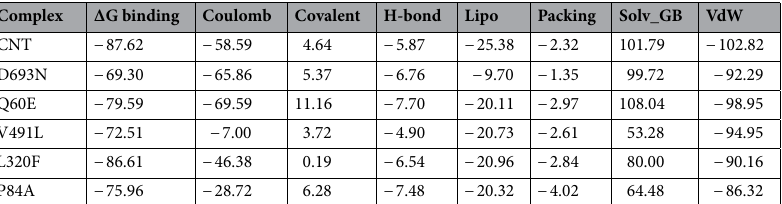
Table 6. Prime MM-GBSA energies for Ligands binding at the active site of COVID-19 main protease. Coulomb Coulomb energy, Covalent Covalent binding energy, VdW Van der Waals energy, Lipo Lipophilic energy, Solv_GB Generalized Born electrostatic solvation energy, H-bond Hydrogen-bonding energy.